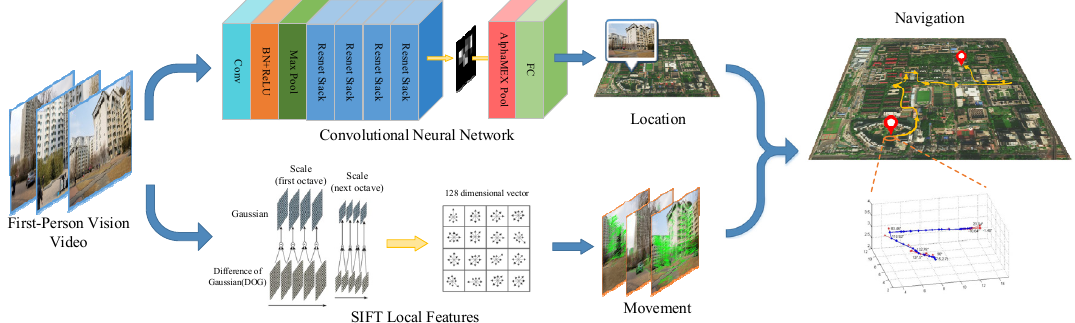
Figure 1. Flow diagram of the proposed FPV (first-person vision) pedestrian navigation algorithm. Solid blue lines represent the flow of sequence frames, whereas solid yellow lines represent the flow of internal functions.